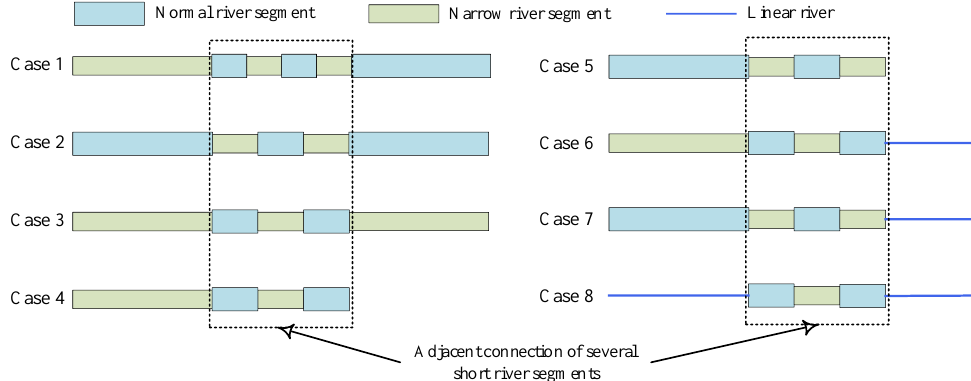
Figure 8. Cases of non-isolated short river segment.